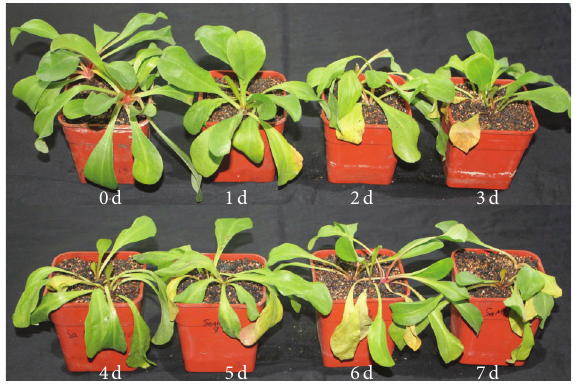
Figure 2: The phenotype of L. sinense seedlings under 500 mmol/L NaCl treatment.